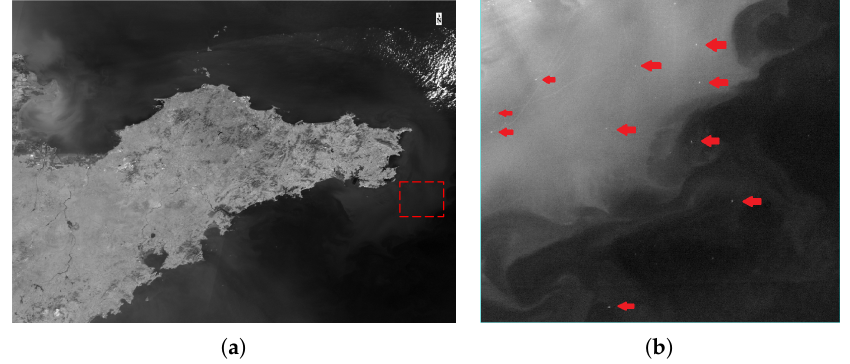
Figure 1. ( a ) Visible light band image of Gaofen-4 (GF-4); ( b ) enlarged image of the red boxed area in ( a